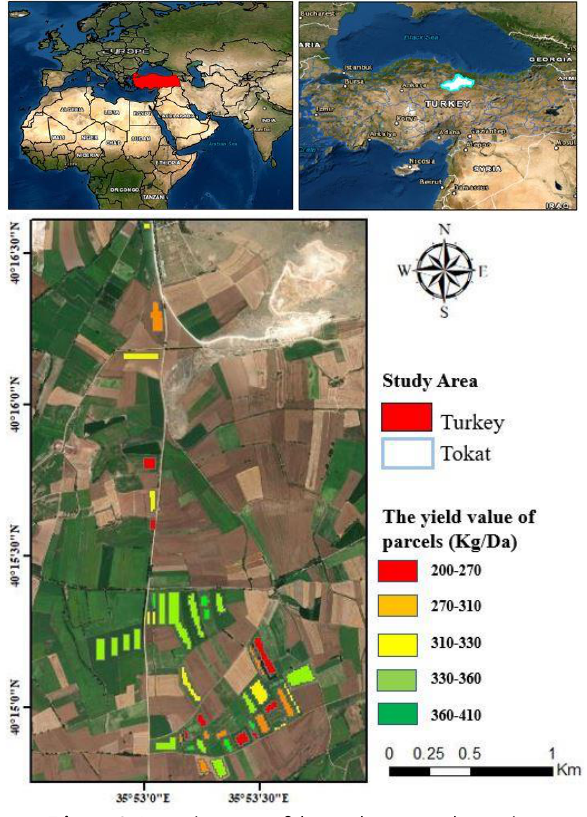
Figure 2. Location map of the study area and test sites.